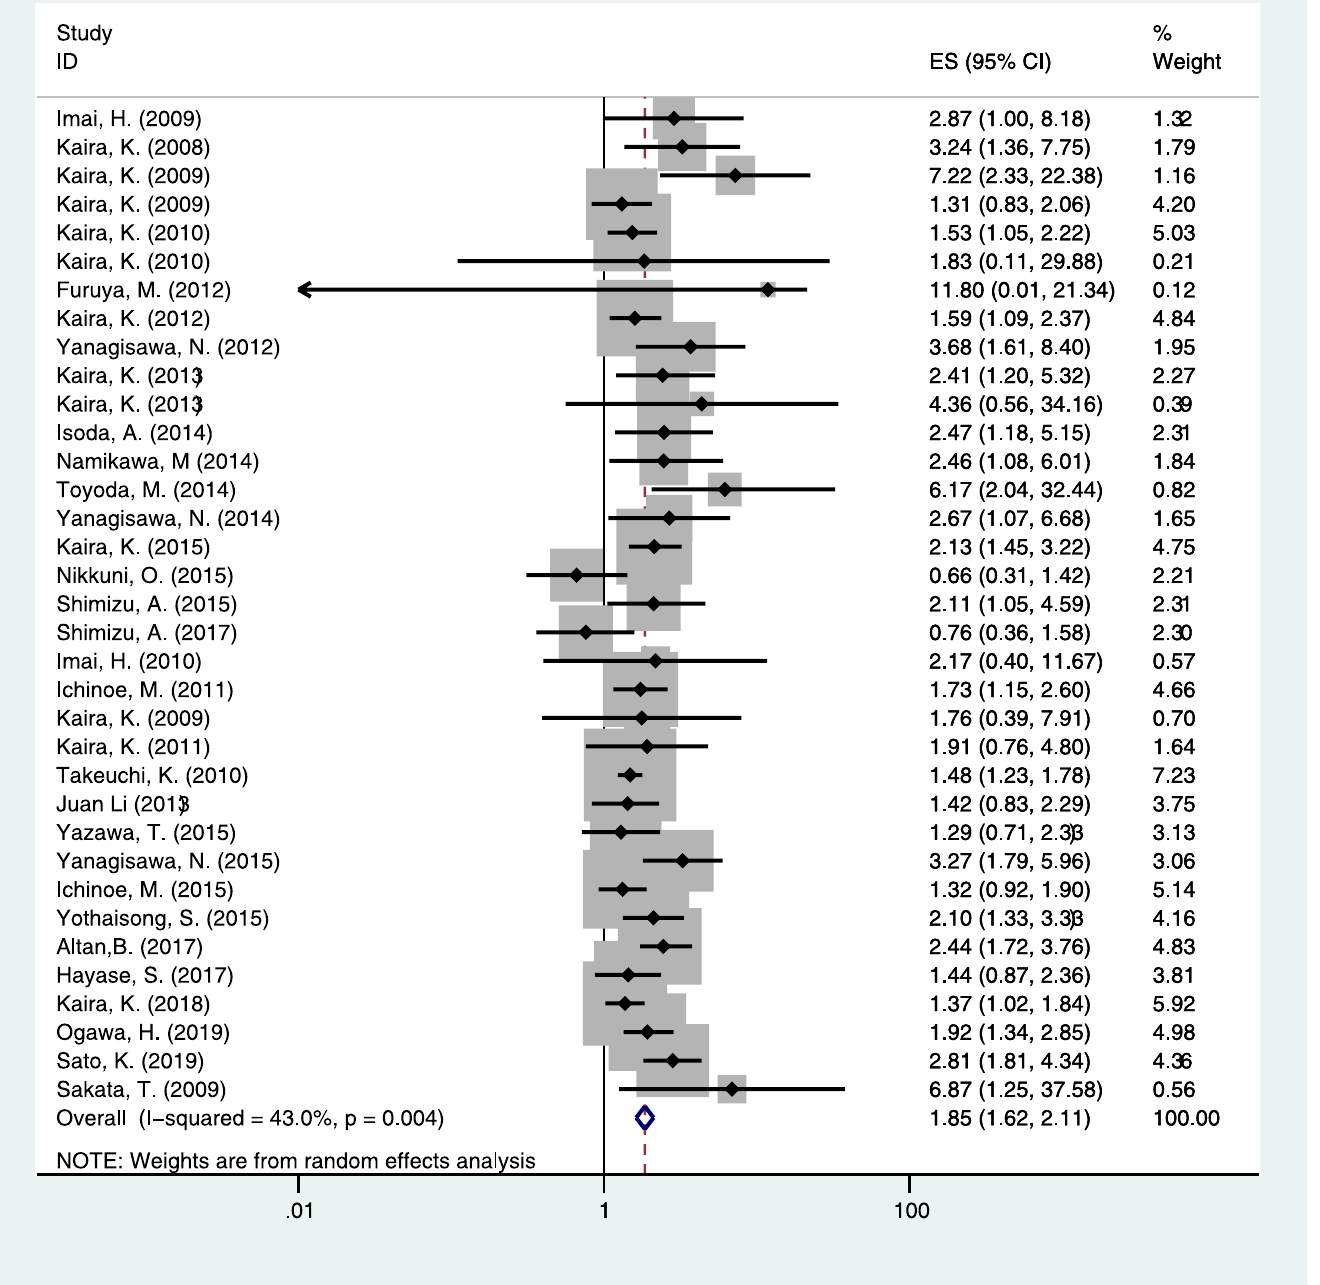
Fig 2. The correlation between LAT1 high expression and overall survival (OS) of solid